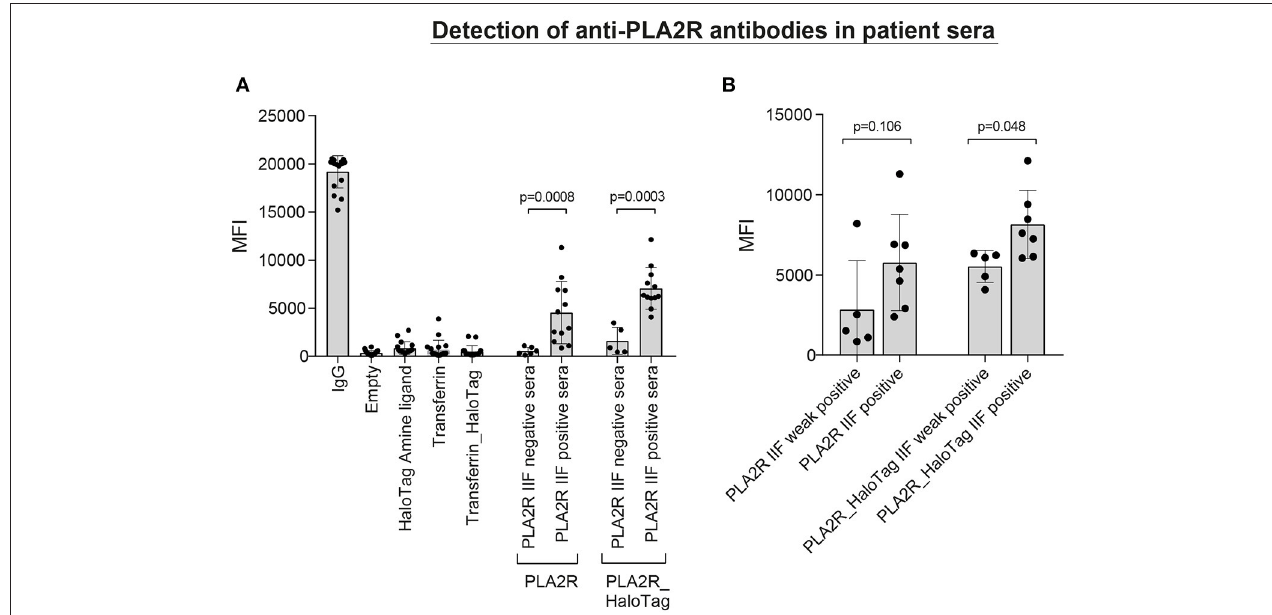
FIGURE 5 | Detection of anti-PLA2R antibodies in patient sera . (A) 18 patient sera [6 negative and 12 positive according to the qualitative anti-PLA2R indirect immunofluorescence test (IIFT)] were incubated with a microsphere mix consisting of empty microspheres and microspheres coupled with HaloTag amine ligand, Transferrin (direct-coupling), Transferrin_HaloTag (together four negative controls), coupled with IgG (positive control), and also two specific microspheres coupled with PLA2R (direct) or PLA2R_HaloTag. The MFI values of each independent patient serum are depicted including the mean and standard deviation. (B) The 12 IIFT positive patient sera can be divided into weak positive ( n = 5) and positive ( n = 7) according to the immunofluorescence staining. Using this stratification, we plotted the MFI values measured in our assay with the two different PLA2R microspheres (direct- and